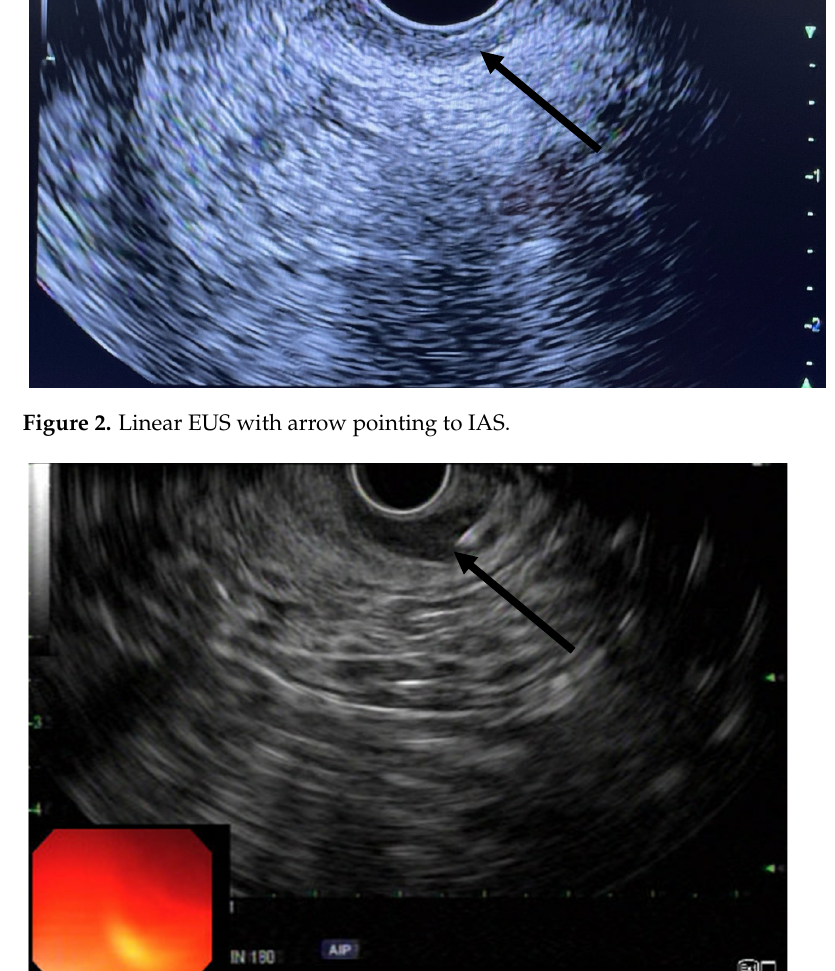
Figure 3. Linear EUS with arrow pointing to the needle injecting the IAS with expansion of the IAS due to the injection.